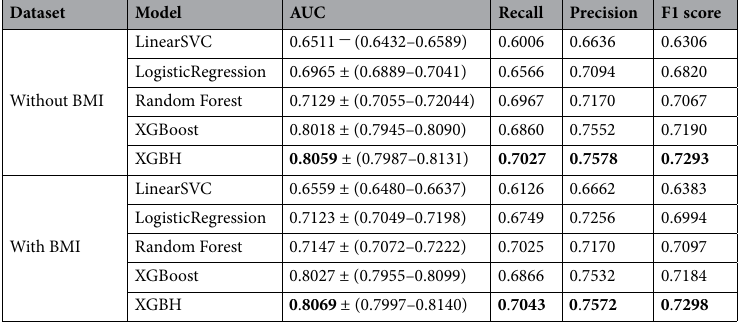
Table 2. Performance of all prediction models under various feature. Values for AUC denoete the mean ± confidence interval (CI). AUC, the area under a receiver operating characteristic cure; Precesion = TP /( TP + FP ) , Recall = TP /( TP + FN ) where TP stands for true positive, TN for ture negative, FP for false positive, and FN for false negative; F 1 score = 2 ( precision ∗ recall )/( precision + recal ) .